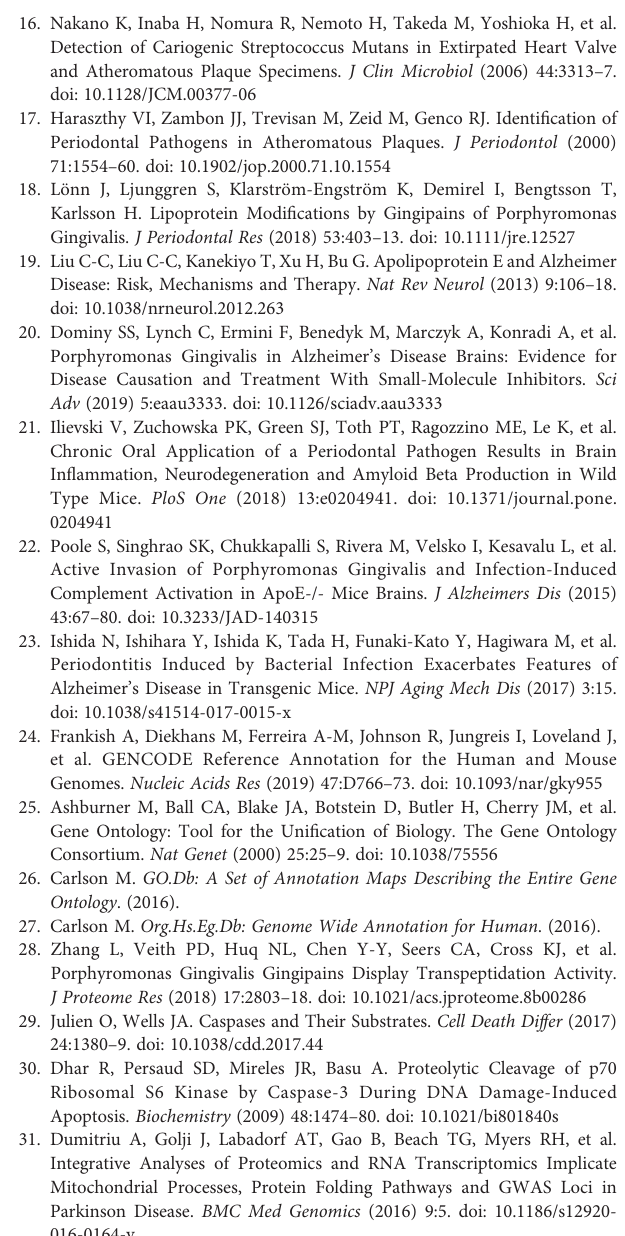
Supplementary Table 4 | Results of differential expression tests for P. gingivalis detection. Supplementary Table 5 | Gene Ontology enrichment results for genes associated with P. gingivalis detection. Supplementary Table 6 | Neuroanatomical enrichment results for genes associated with P. gingivalis detection. Supplementary Table 7 | Nervous system cell-type enrichment results for genes associated with P. gingivalis detection. Supplementary Table 8 | Neuroanatomical enrichment results for the SRP- dependent cotranslational protein targeting to membrane genes.